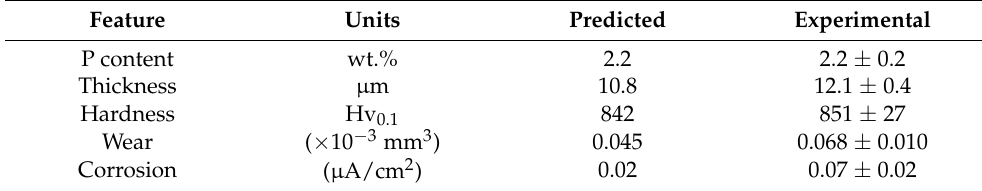
Table 10. Predicted and experimental values of ENP coatings subject to multivariate optimization. Feature Units Predicted Experimental P content wt.% 2.2 Thickness